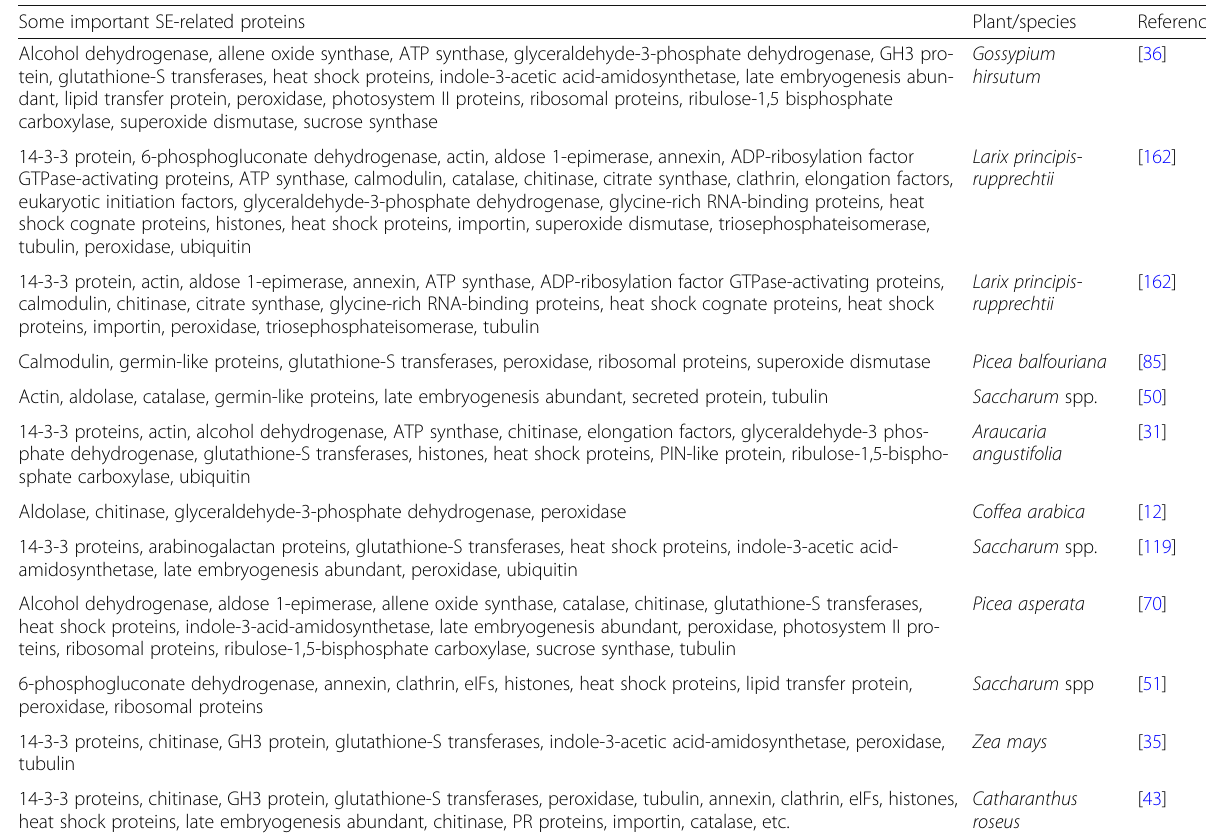
Table 3 Plants and different SE related proteins, identified through LC-MS Some important SE-related